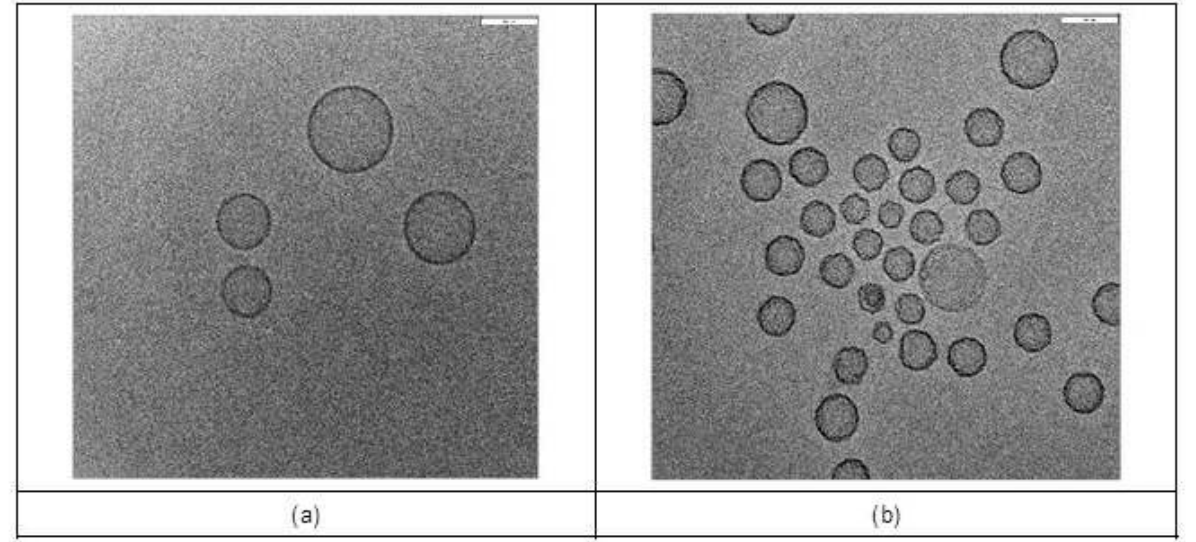
Figure 2. Representative Cryo-TEM micrographs of Si306-loaded liposomes. Images of ( a ) LP[Si306] and ( b ) GD2-LP[Si306], obtained by Cryo-TEM analysis. Bar: 80 nm. The average thickness of the phospholipidic bilayer was 7.02 nm for LP[Si306] and